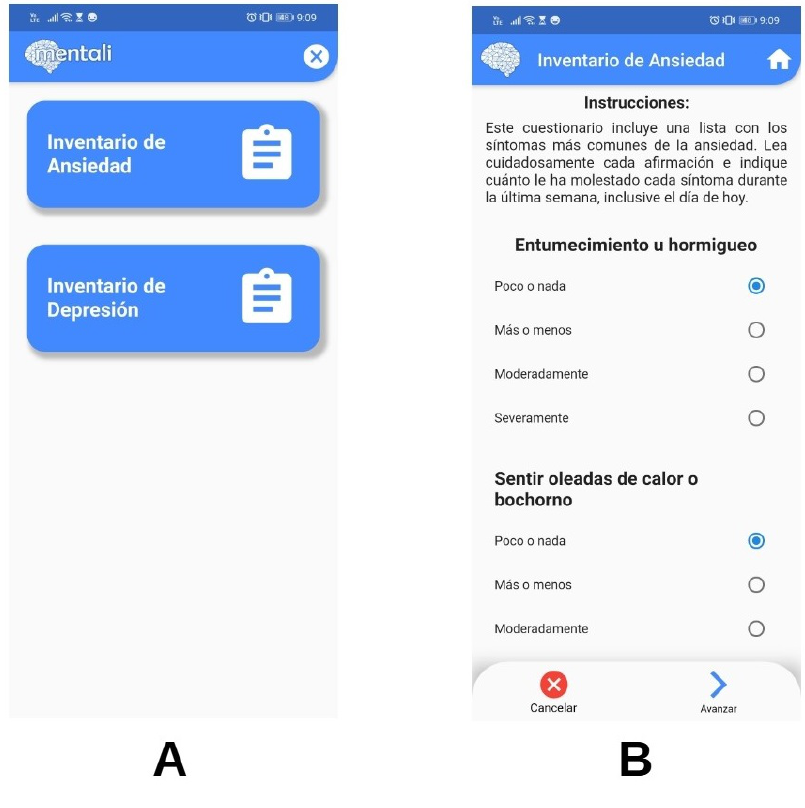
Figure 9. Select inventory ( A ) and anxiety inventory ( B ) screens.